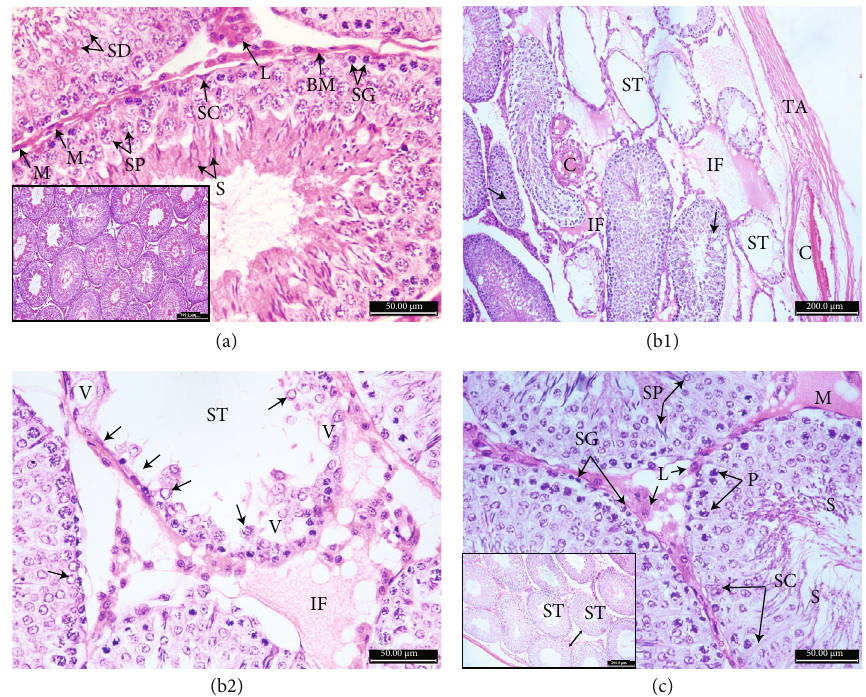
Figure 3: Photomicrographs of H&E-stained sections from the rat testis. (a) Control testis showing normal seminiferous tubules lined by spermatogonia (SG), lying on regular basement membranes (BM), primary spermatocytes (SP), rounded spermatids (SD), mature sperms (S) inside the lumen, Sertoli cells (SC), interstitial tissues containing Leydig cells (L), and fl at nuclei of myoid cells (M). (b) MTX group showing disruption of seminiferous tubules (ST) with complete loss of spermatogenic cells and Sertoli cells and some tubules with sloughing of germ cells into the tubular lumens with loss of sperms (arrowheads). Congested blood vessels (C), tunica albuginea (TA), and oedema in interstitial tissue (IF). (c) MTX group showing complete loss of spermatogenic cell lines and Sertoli cells (arrows), cells having nuclei with chromatin margination (arrowheads), vacuolations (V) with loss of mature sperms, and oedema in interstitial tissue (IF). (d) ADMSC-treated testis showing normal seminiferous tubules and myoid cells (M), lined by normal spermatogonia (SG), spermatocytes (P), spermatids (SP), sperms (S), and triangular Sertoli cell (SC) resting on the intact basement membrane. Interstitial tissues contain Leydig cells (L) (H&E × 400, photo inside frame, ×